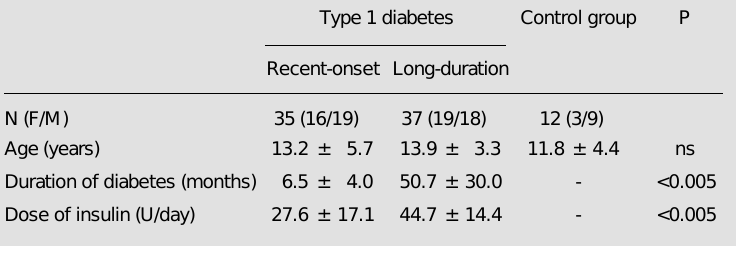
Table 1 - Clinical characteristics of type 1 diabetes patients and control subjects.